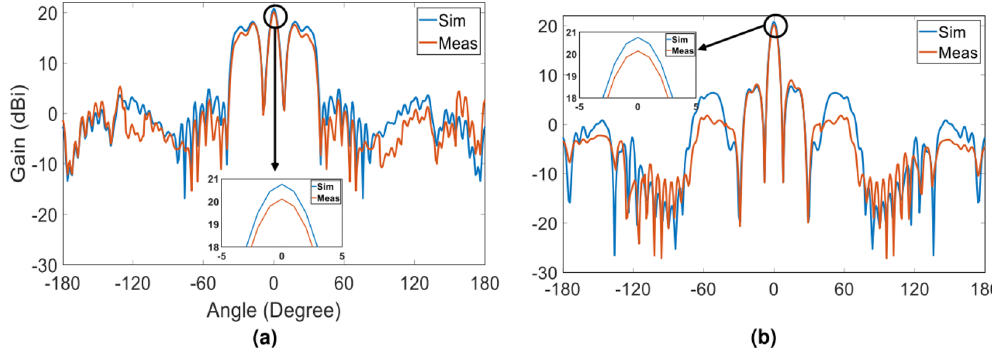
Figure 12. The comparison between the simulation and measurement results of the fabricated hologram in ( a ) phi = 90 and ( b ) phi = model of the pattern of the feed as ( A 0 cos q θ ), which can be computed with CST MWS by comparing that analyt- ical model with the radiated far-field pattern of the feed. In light of the above discussion, the antenna efficiency described in the last example will be obtained 55.89 %. conclusion A systematic method is presented to design a shaped-beam emitter reflector-based metasurface. The method combines the holography concept and convolution theorem together and introduces a novel synthesis method for shaping EM waves with flexible and continuous control of the beam direction without using any optimization algorithm and extra computational cost. Using the holography and convolution theorem gives the designer a new insight for implementing versatile radiation patterns from a new point of view. It is shown that the method is independent of the object shape and also the object number. Furthermore, the method has the potential to be used in such structures with simultaneous demonstration of several functionalities for the beam direction and beam shaping. This may be done by incorporating active devices as the realization approach of the hologram impedance profile.